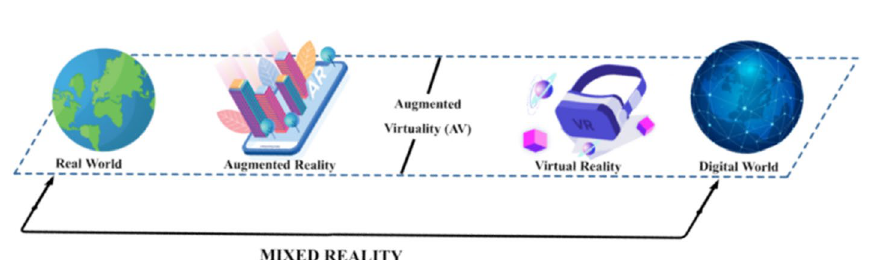
Fig. 2 The differences between virtual, augmented and mixed